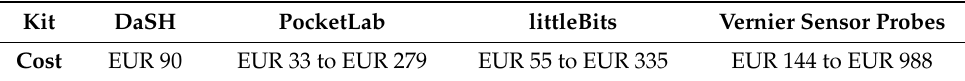
Table 1. Comparison between the cost of the DaSH and kits that can have similar functionality. Commercially available kits that included programmable sensors with educator friendly interfaces and learning materials were chosen as a comparison. Cost depends on what sensors are included and how students interact with the system. Prices retrieved on 3 September 2021 from https://www.thepocketlab. com/store, https://sphero.com/collections/all/family_littlebits+type_kit?sort_by=price-ascending, and Prices retrieved from https://www.vernier.com/product-category/?category=go-direct-packages& page_num=1.